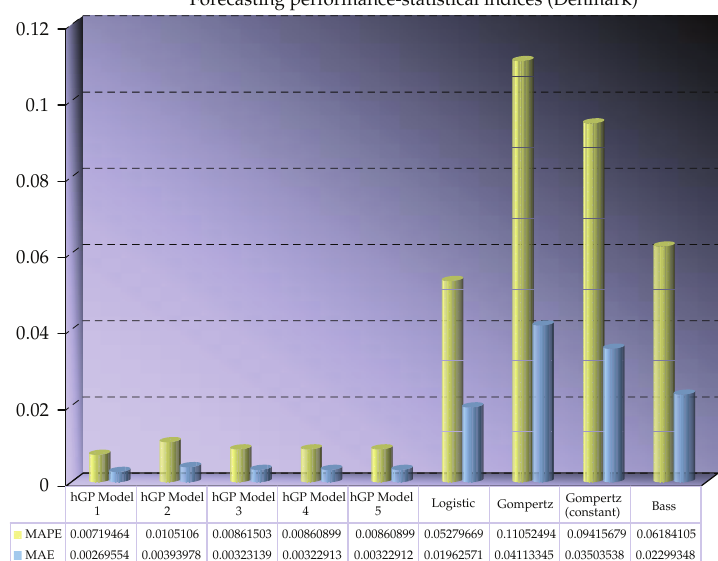
Figure 28: The forecasting performance of the optimized di ff usion models for Denmark (cid:2) forecast period—2 years ahead (cid:3)